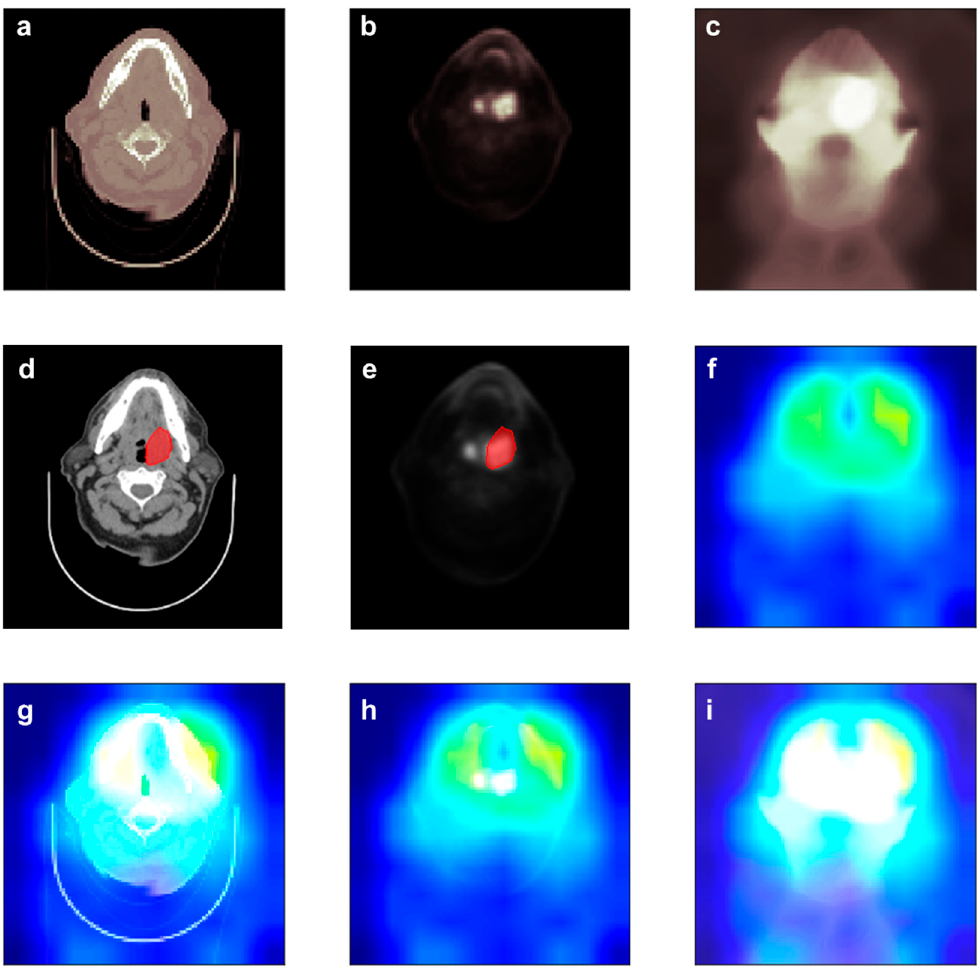
Figure 5. Heat map of an LR negative patient produced by the CPD model: ( a ). Input images of CT. ( b ). Input images of PET. ( c ). Input images of dose distribution. ( d ). Contour images of CT. ( e ). Contour images of PET. ( f ). The heatmap. The red region in the heatmap indicating the important region to make decision of LR. ( g – i ) are superimposed images of CT, PET, and dose distribution and heatmap, respectively.